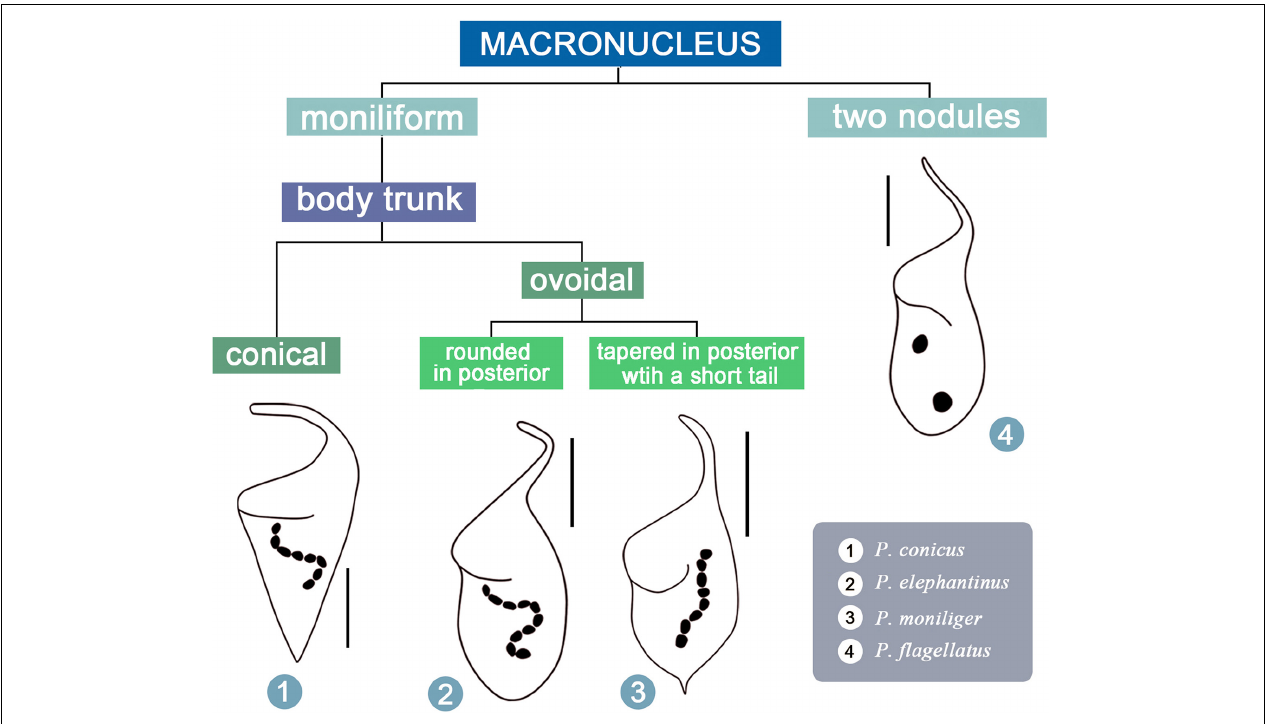
FIGURE 9 | Illustrated key to valid Paradileptus